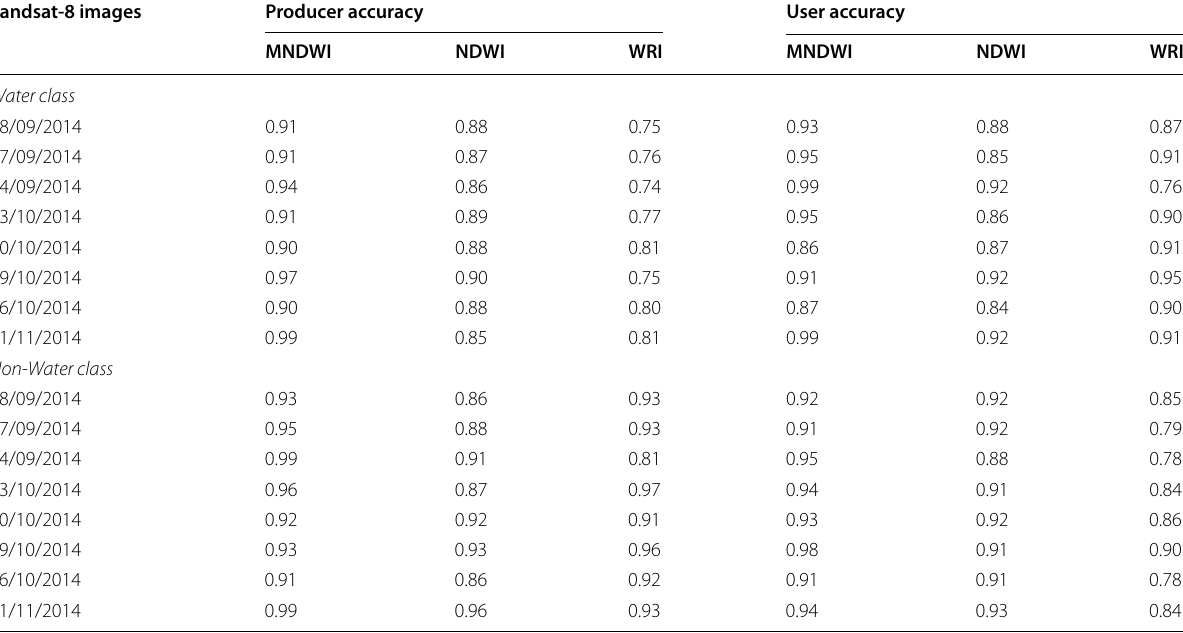
Table3 User and producer accuracy of RFM generated from used water indices Landsat-8